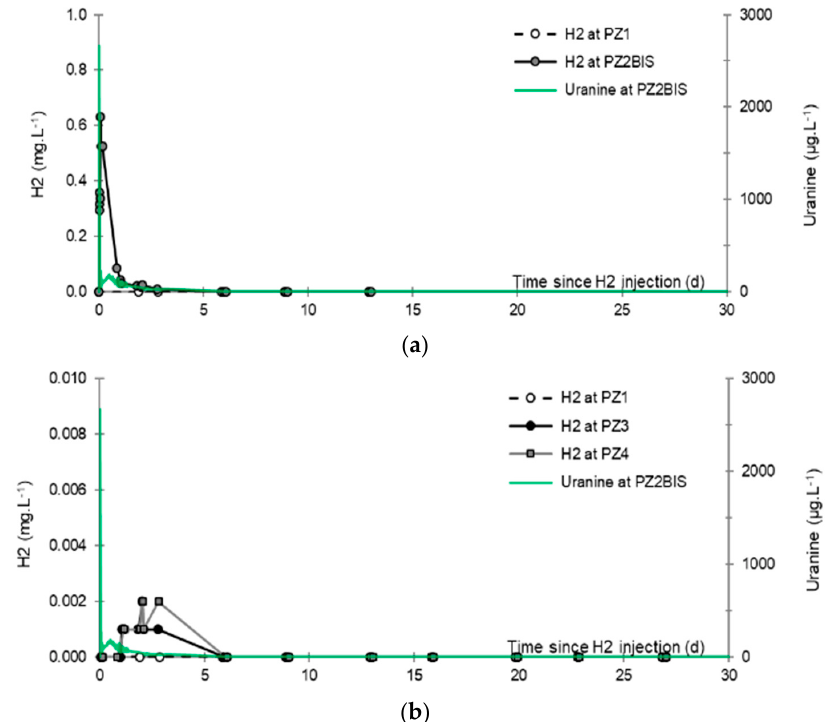
Figure 12. Comparative evolution of dissolved H 2 and tracer concentrations at the different piezometers: ( a ) PZ1 (20 m upstream) and PZ2BIS (5 m downstream); and ( b ) PZ1 and PZ3 (10 m downstream) and PZ4 (20 m downstream).